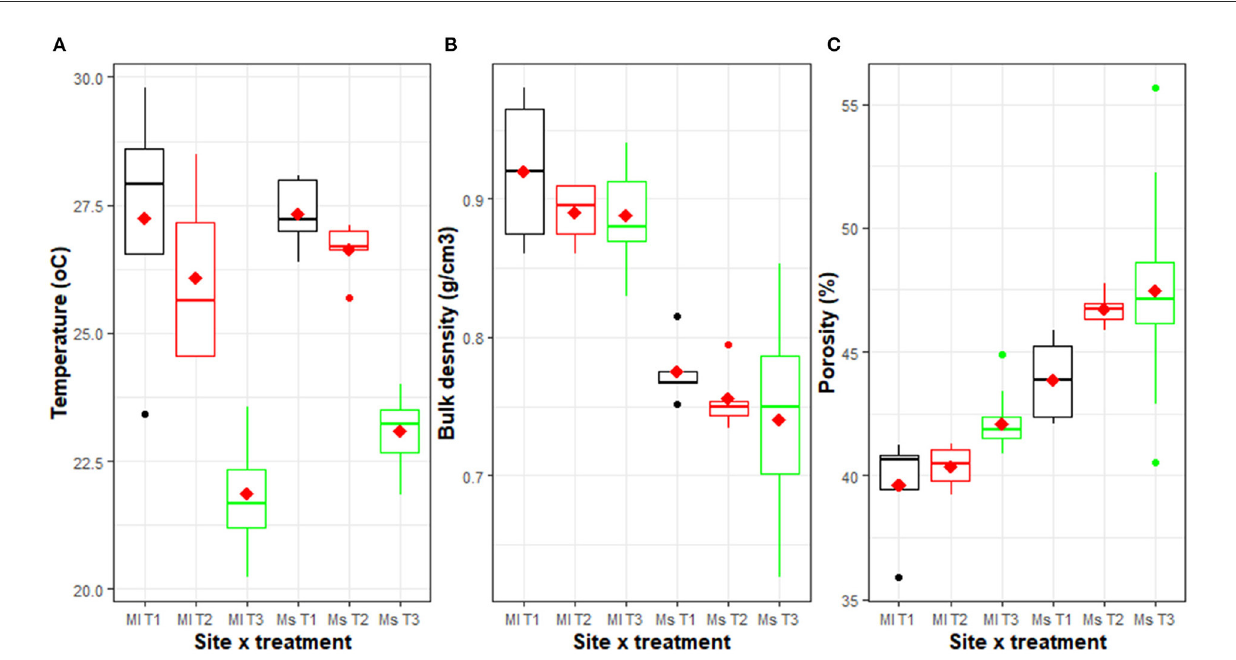
FIGURE4 Soil temperature (A) , bulk density (B) , and porosity (0–20cm soil layer) (C) across three management packages (T3, T2 and T1) and two sites [Mulungu (Ml) and Mushinga (Ms)], measured 4 years after trial establishment. The management practices included, T3: an improved agroforestry practice in which grasses, shrubs and mucuna cover crop had been integrated, T2: burning of weeds and crop residues with NPK and manure application, and T1: burning of weeds and crop residues without NPK and manure application. The horizontal line within each box is the median, while the diamond shaped symbol within the box is the mean. The lower and upper boundaries of the boxes are respectively, the 25th and 75th percentile; the bars/whiskers below and above the b ox are the 10th and 90th percentile and points beyond 10th and 90th percentiles are